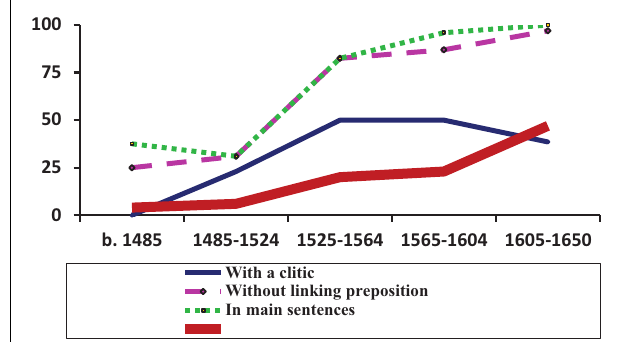
FIGURE 1 | Percentage values (for each time period) for different schemas and global, relative frequency of all schemas of the Infinitive + tener